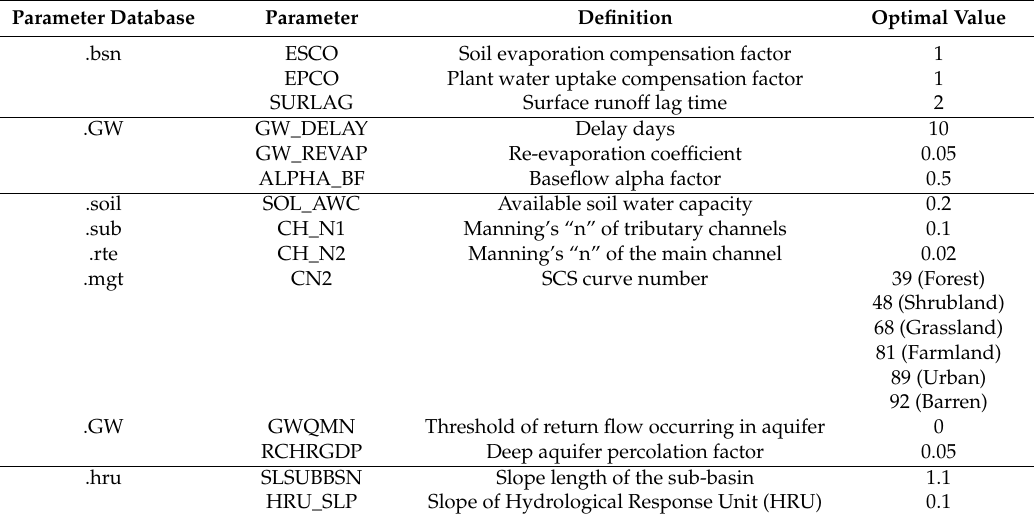
Table 1. Parameters of the SWAT model used to calibrate baseflow in the Upper Du